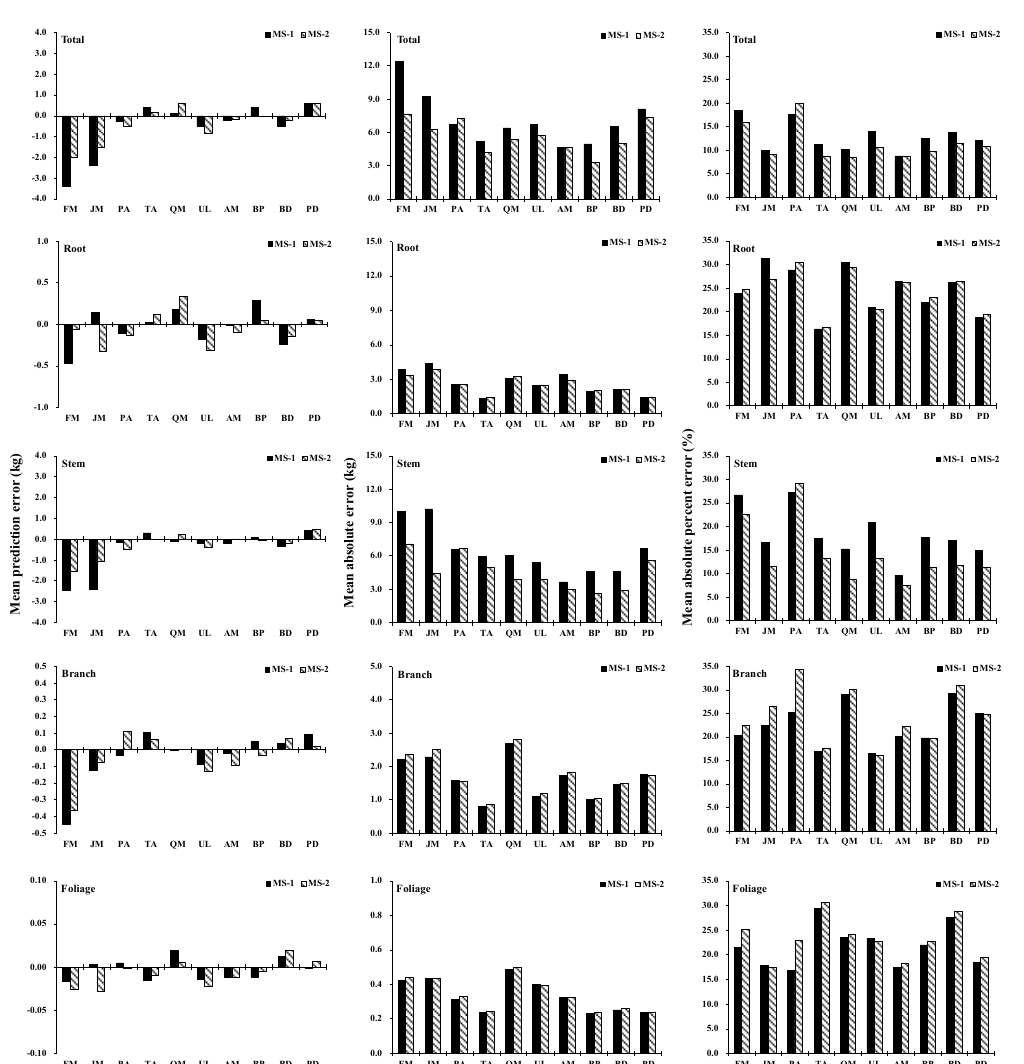
Figure 3. Mean prediction error (MPE), mean absolute error (MAE), and mean absolute percent error (MAE%) among the total and component biomass for the 10 tree species. FM: Fraxinus manshuric ; JM: Juglans mandshurica ; PA: Phellodendron amurense ; QM: Q uercus mongolica ; TA: Tilia amurensis ; UL: Ulmus laciniata ; AM: Acer mono ; BP: Betula platyphylla ; BD: Betula davuria ; PD: Populus davidiana .